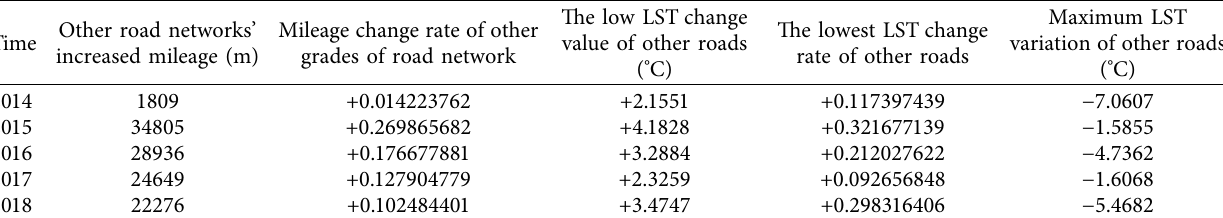
mileage rise percentage is better than the high LST increase, indicating that there is a linear coupling relationship be- tween other grades of road network and its LST. Other